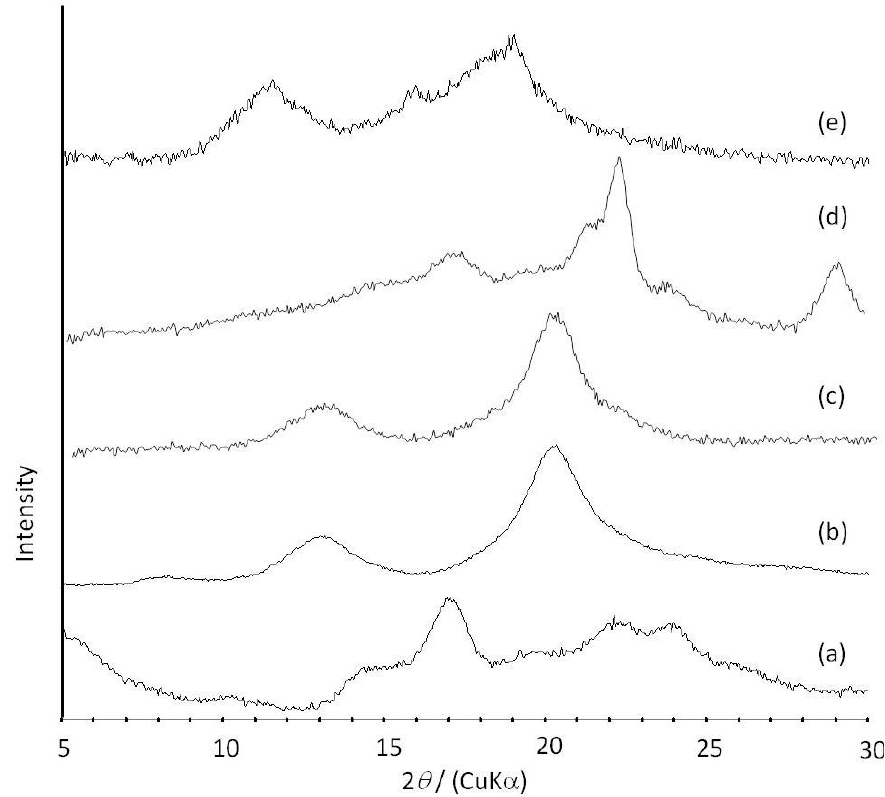
Figure 6. XRD profiles of amylose ( a ); amylose-PTHF inclusion complex ( b ); amylose-P(GA- co -CL) inclusion complex ( c ); the product obtained by vine-twining polymerization using P(GA- b -CL) ( d) ; and amylose-PLLA inclusion complex ( e